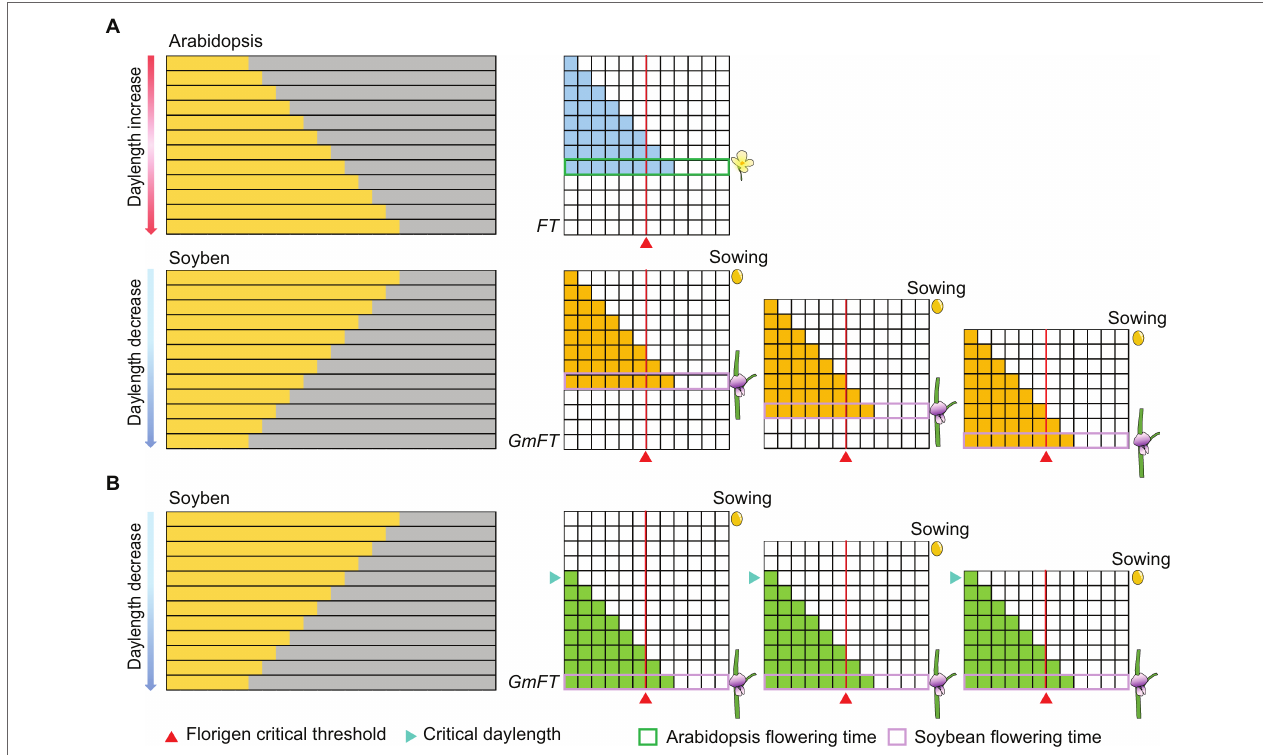
FIGURE 4 | Expression patterns of florigen in different models. (A) Expression patterns of florigen change gradually with daylength. Florigen expression gradually increases with daylength; the plants flower when a critical threshold is reached. (B) Expression patterns of florigen with critical daylength threshold. The florigen genes begin to be expressed when the daylength is shorter than the critical daylength, resulting in flowering of soybean when the critical threshold is reached. The number of filled horizontal squares represents the mRNA levels of florigen. The red triangle represents the critical threshold of florigen. The cyan triangle represents the critical